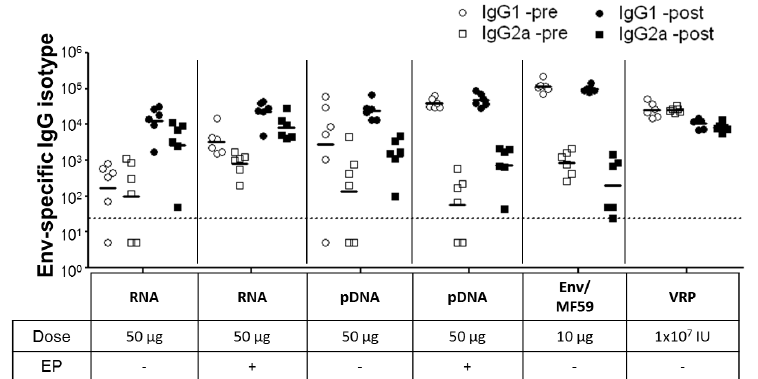
Figure 4. Env-specific IgG1 and IgG2a titers in mice sera were measured at 2wp2 (pre-) and 2wp3 (post-protein boost) for nucleic acid vectors with or without EP (RNA and pDNA; 50 µg), MF59-adjuvanted Env (Env/MF59, 10 µg) or viral replicon particles (VRP, 1 × 10 7 IU) primed groups. Individual titers are plotted and the horizontal bar represents geometric mean titer (GMT) for each group (n = 6 per group). Titers <25 (dotted line) were assigned a value of 5 for calculation of GMT.